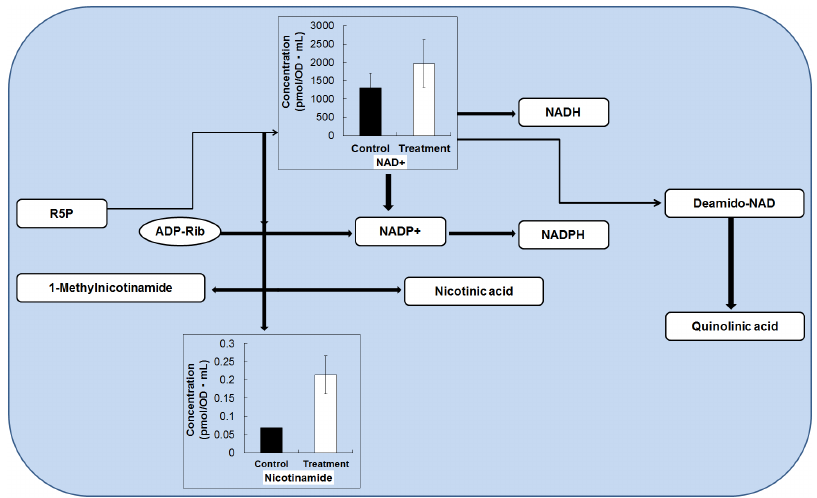
Fig 4. Metabolite changes in the nicotinamide metabolism by L . plantarum fermentation. Changesin the metabolitelevels in the fermented O . japonicus by L . plantarum (gray bars) comparedwith those in the O . japonicus with L . plantarum (black bars) determined by capillaryelectrophoresis time of flight mass spectrometry (CE-TOF-MS). The error bar indicatesthe mean standard deviationof triplicate samples. The figure also includesa schematic diagram of nicotinamide